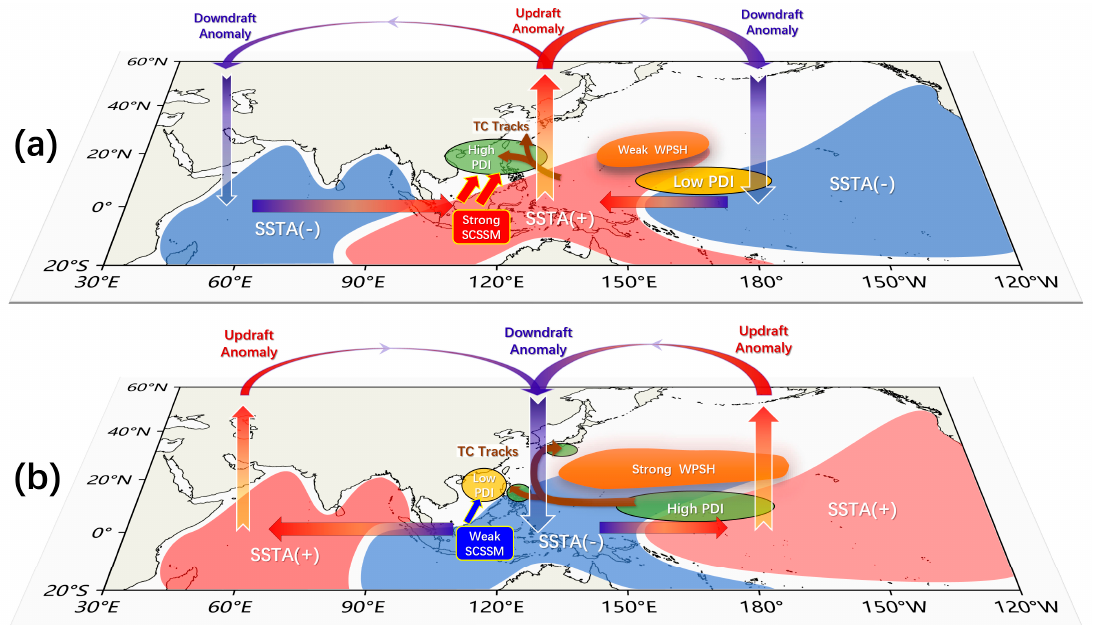
Figure 11. Mechanism diagram of the tropical Indo-Pacific ocean–atmosphere system and TCs activity characteristics in ( a ) strong and ( b ) weak SCSSM years.